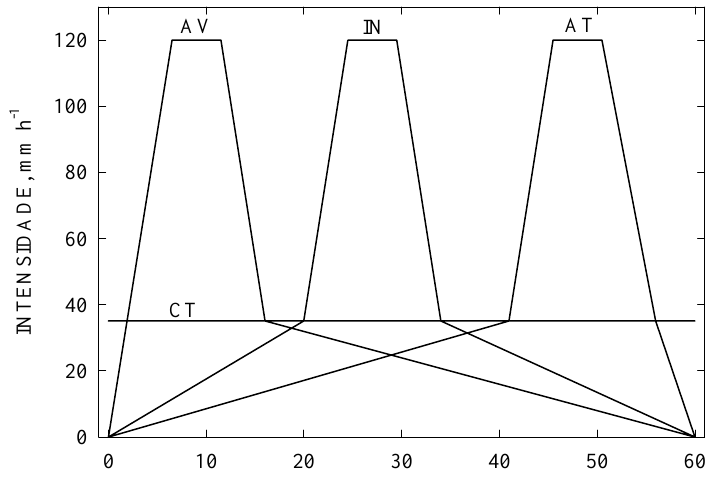
Figura 2. Representação dos padrões de chuva avançado (AV), intermediário (IN), atrasado (AT) e constante (CT) utilizados neste